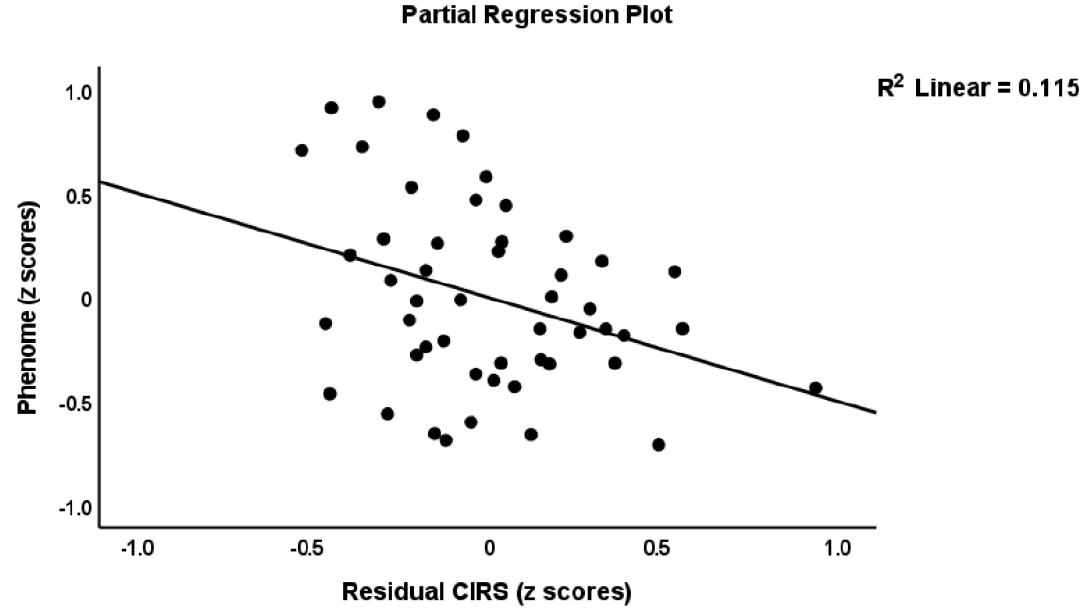
Figure 3. Partial regression of the phenome score on an index of the compensatory immune-regulatory system.